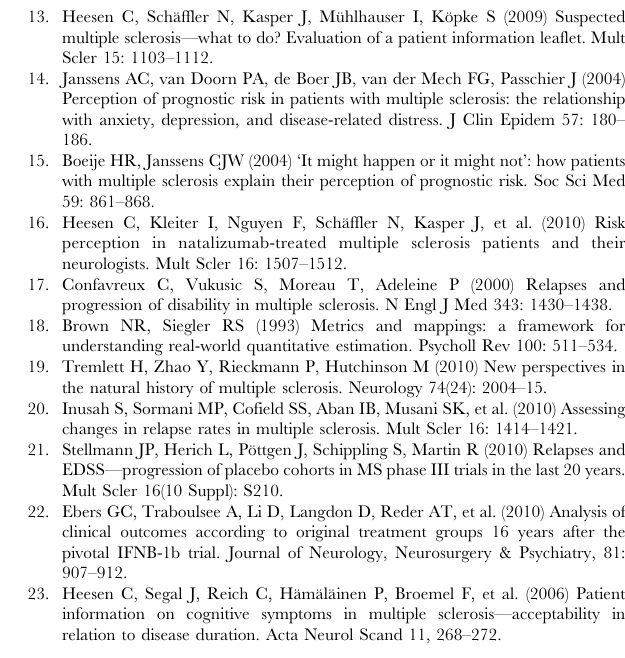
Figure 3. Correlations between risk estimates and disease covariates. Data are shown separately for patients (at baseline and after exposure to the OLAP tool), physicians, and the OLAP tool. Patients’ and physicians’ estimates correlated most strongly with those factors that also correlated most strongly with the OLAP tool’s predictions, both regarding the risk of EDSS 6 or higher after 3 years (upper panel) and relapses after 18 months (lower panel). Note: Course of the disease was given a value of 1 for CIS and RRMS and a value of 2 for SPMS and